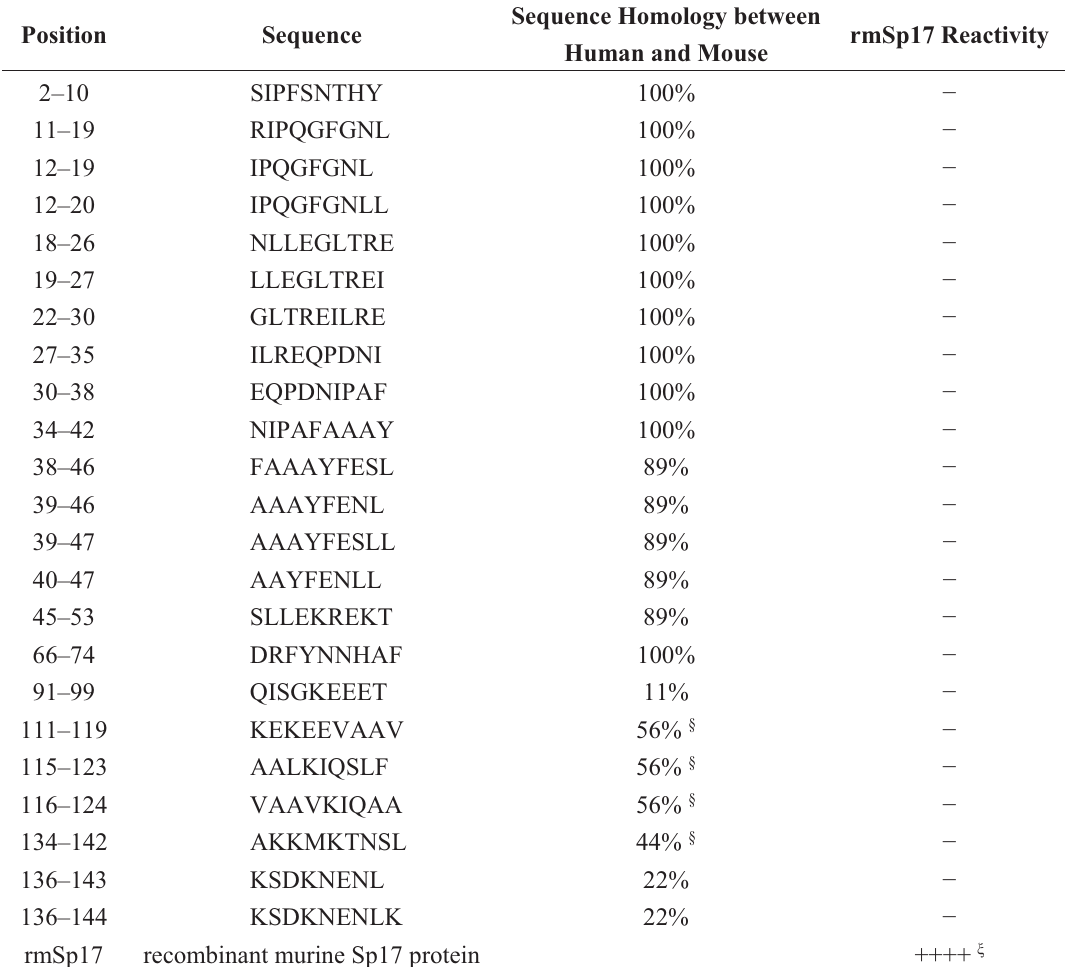
Table A1. Screening for potential CD8 T cell epitopes* in rmSp17 protein conjugated to PSNPs in both C57BL/6 and HLA-A2.1 mice #